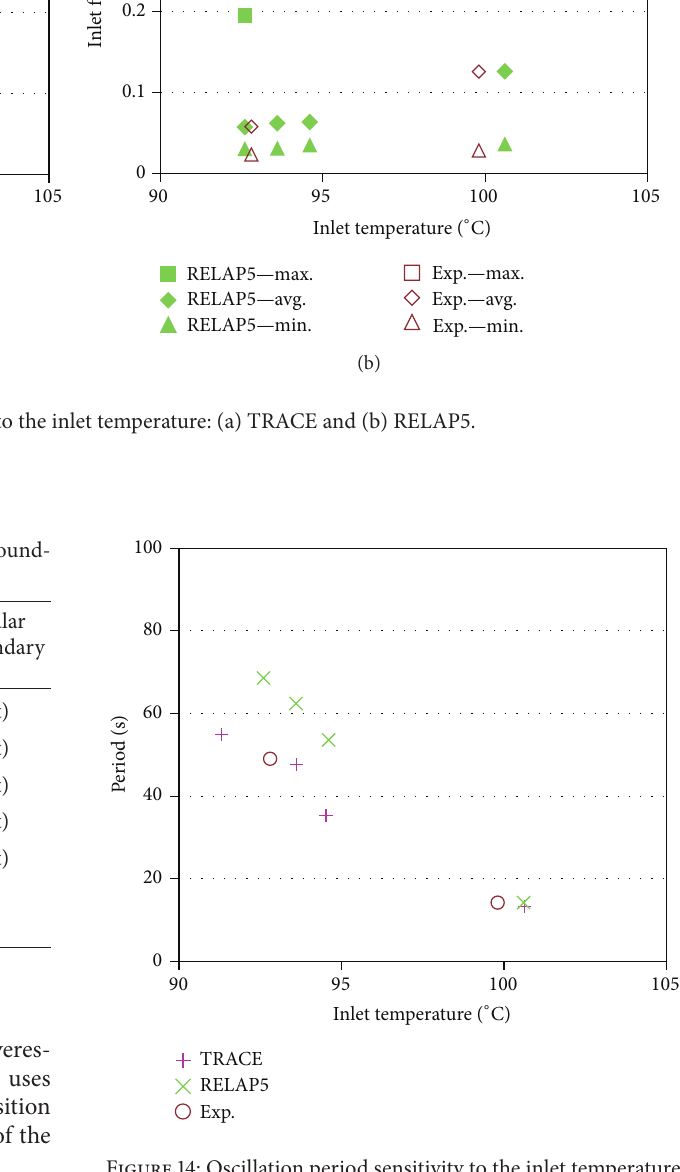
Figure 14: Oscillation period sensitivity to the inlet